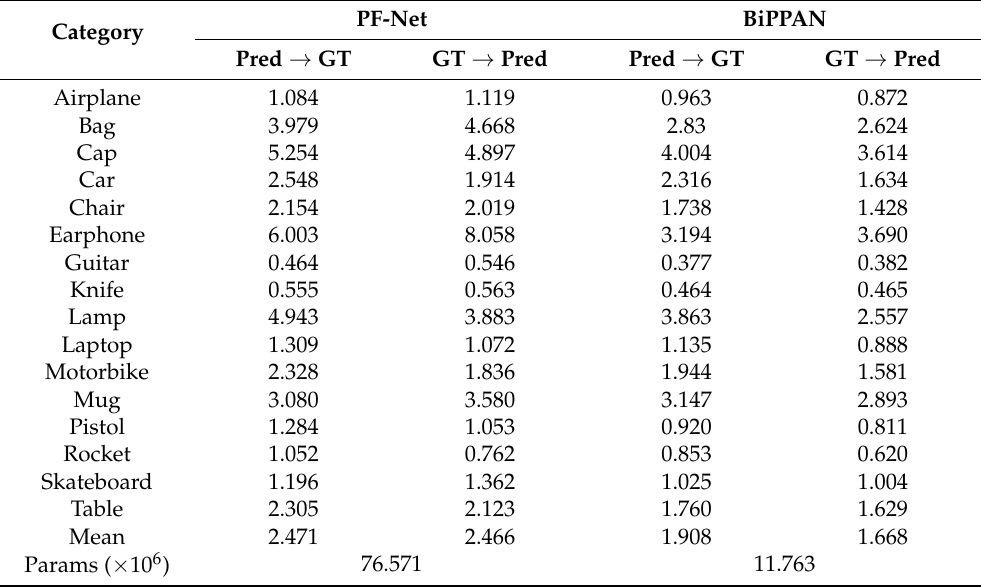
Table 2. Results of a comparison between our method and PF-Net on ShapeNet-16 dataset. We also provide the number of parameter (Params) in the last